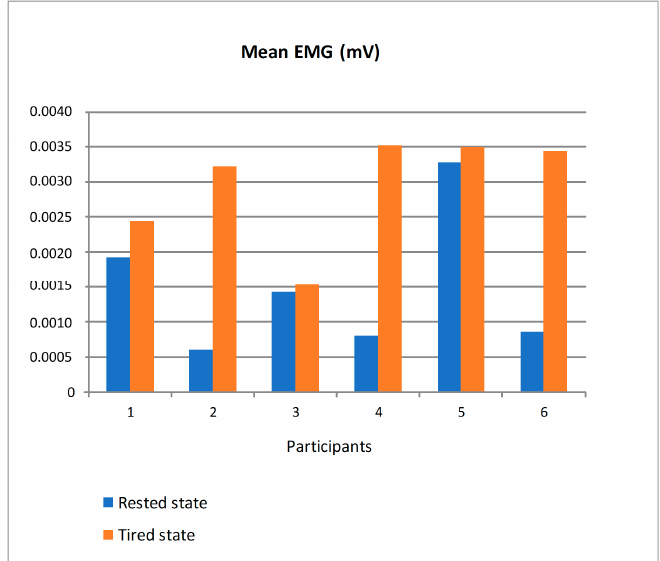
Figure 19. Mean EMG of the participants in rested and tired state.